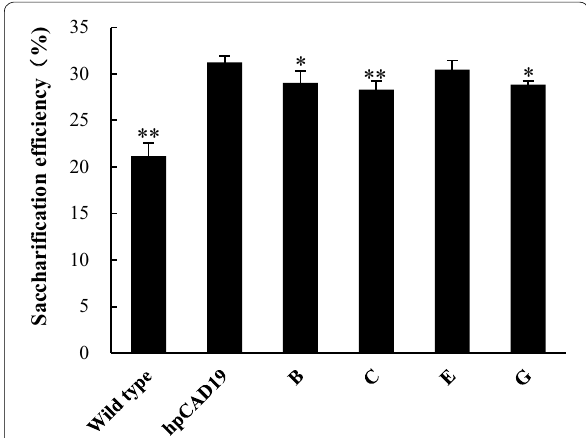
RNA gene in each plant. Data were obtained from three biological replicates. Error bars indicate the standard deviation. Different letters indicate statistically significant differences between the wild-type and the transgenic lines at P < 0.01. A statistical difference was determined by one-way ANOVA followed by Dunnett’s test. Figure S2. Moisture content of debarked fresh stems. The value was calculated based on weight of debarked stem wood immediately after harvest compared to air-dried wood. A statistical difference was determined by one-way ANOVA followed by Tukey multiple comparison tests. Significant differ- ences from hpCAD19 line values at P < 0.05 and 0.01 are represented as * and **, respectively. Error bars indicate the standard deviation. Figure S3. Lignin content in stem wood prepared from different lines. A significant increase in value was only detected in line #B compared to the wild-type line ( P < 0.05) by one-way ANOVA followed by Dunnett’s test. Error bars indicate the standard deviation. Figure S4. Monomeric composition of lignin evaluated by thioacidolysis and subsequent gas chromatography. Conventional thioacidolysis products with guaiacyl (G) and syringyl (S) nuclei were quantified by gas chromatography equipped with a flame- ionization detector after trimethylsilylation. Each value is expressed as a relative level of the amount detected in the hpCAD19 line. Significant differences from hpCAD19 line values at P < 0.05 and 0.01 are represented as * and **, respectively, using one-way ANOVA followed by Dunnett’s test. The values are the mean of three independent biological replicates. Error bars indicate the standard deviation. Figure S5. Detection of indene compounds released by thioacidolysis of lignins. Thioacidolysis-released indenes (1 G1 , 1 S1 , and 1 S2 ), which are indicative of the incorporation of coniferaldehyde and sinapaldehyde into the lignin in CAD suppressed plants, could be detected in the transgenic lines but not in the wild-type plant by GC/MS analysis. Peaks labeled 1 G1 , 1 S1 , and 1 S2 correspond to the indenes with different structures. Detection of the compounds indicates CAD expression is still suppressed in the plants with OsSWN1 as in the hpCAD19 line.